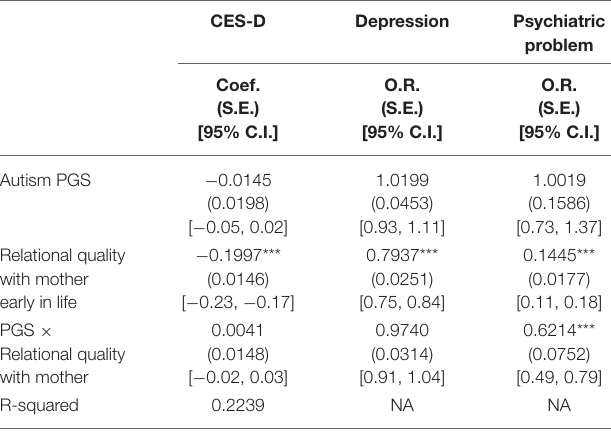
TABLE 3 | Relational quality with mother as a moderator. CES-D